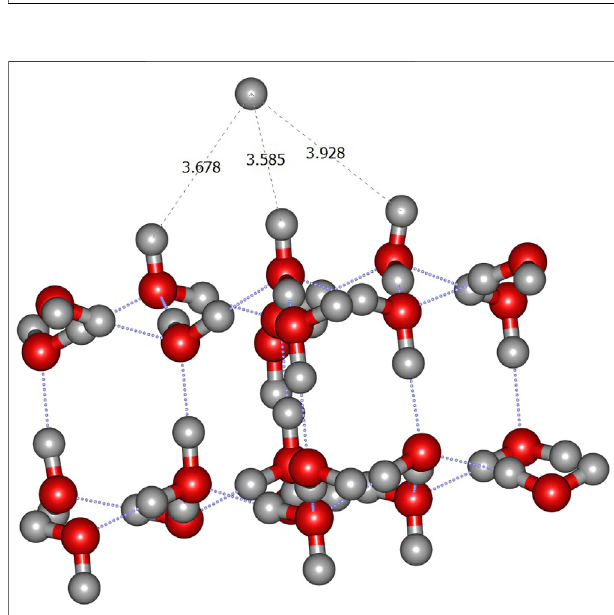
FIGURE 2 | ONIOM( ω B97X-D/6 – 31+G**:PM6) most stable geometry (A1 site) for hydrogen atom on crystalline ice.